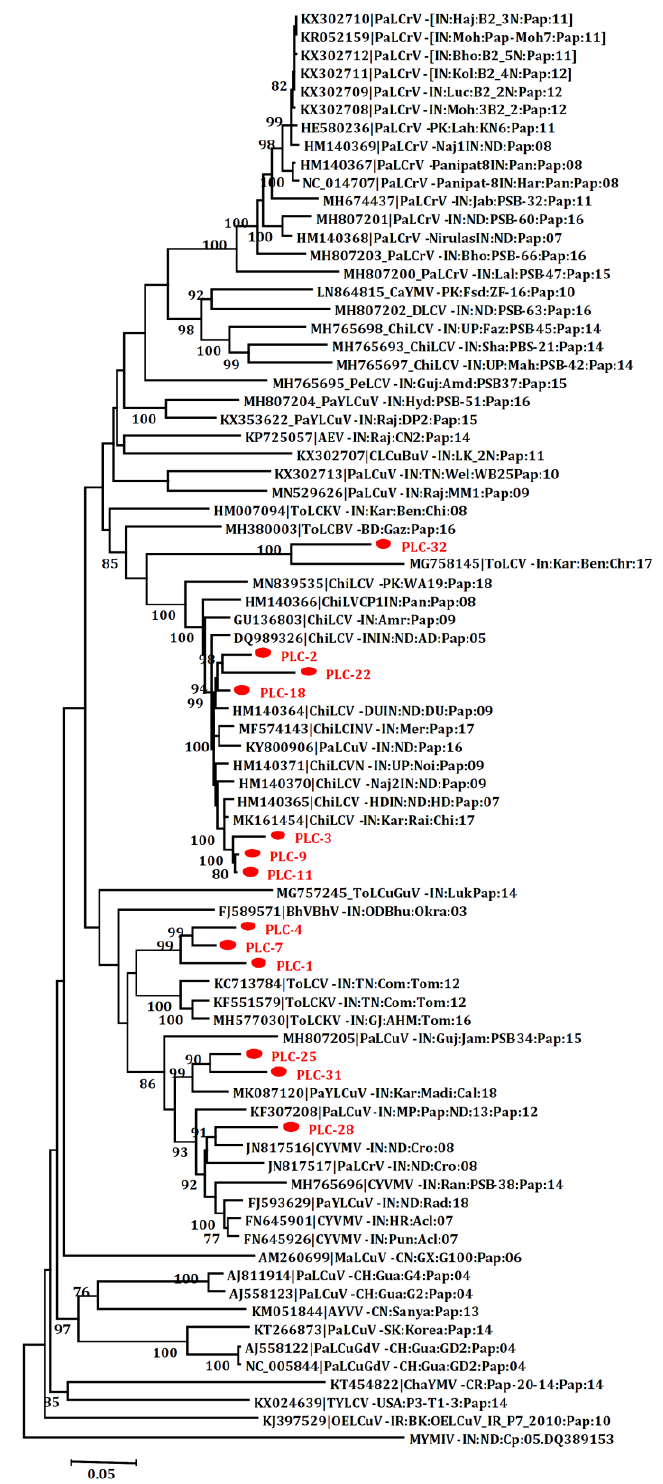
Figure 4. Phylogenic tree showing the relationship of isolated begomoviruses with other selected begomoviruses based on their full-length DNA-A genome nucleotide sequence (The number of each node indicates 60 percentage bootstrap value with 1000 replicates).